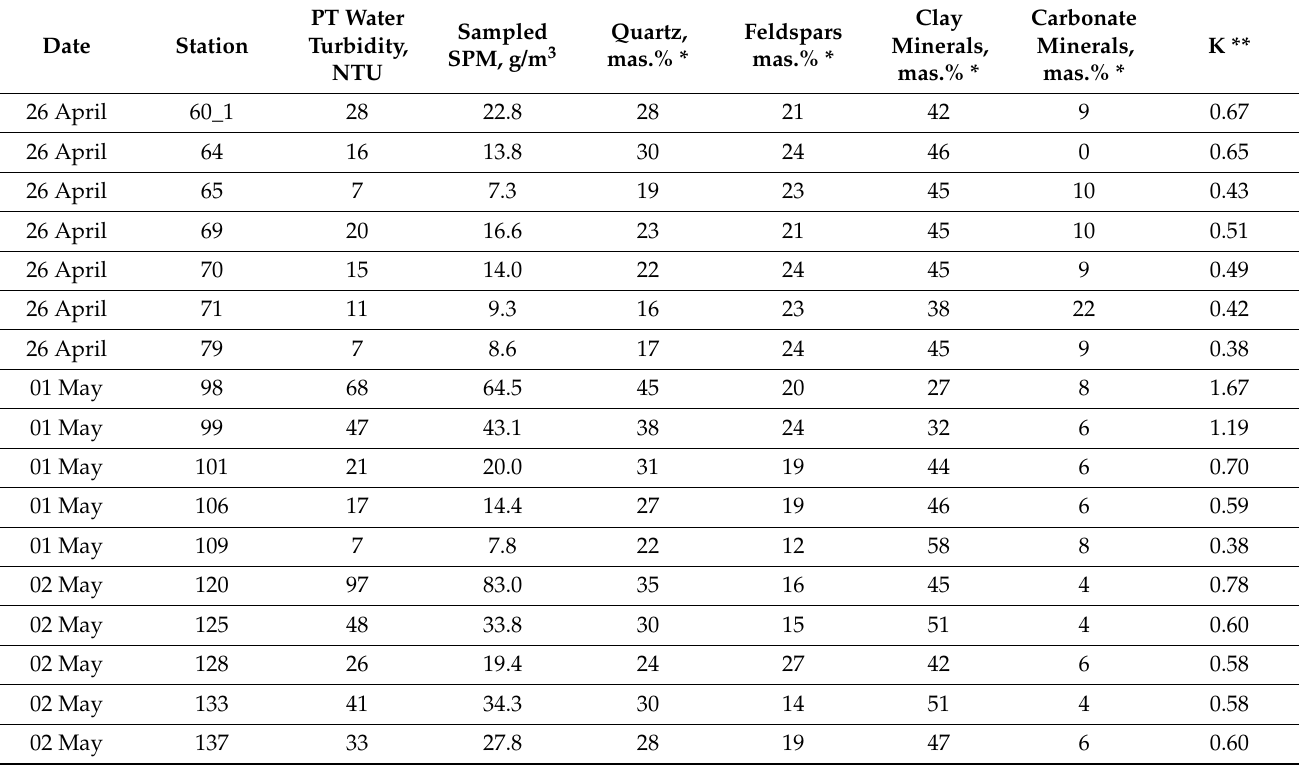
Table 4. Turbidity in the upper near-surface layer, sampled SPM and mineral composition of